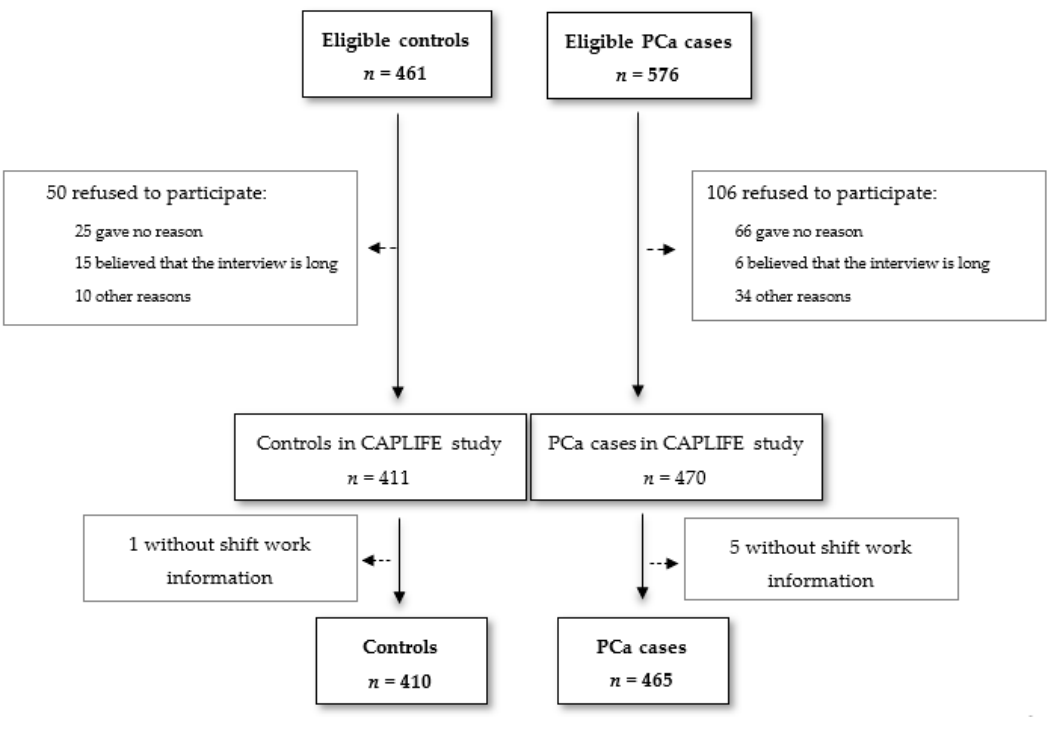
Figure 1. Flow-chart CAPLIFE study.